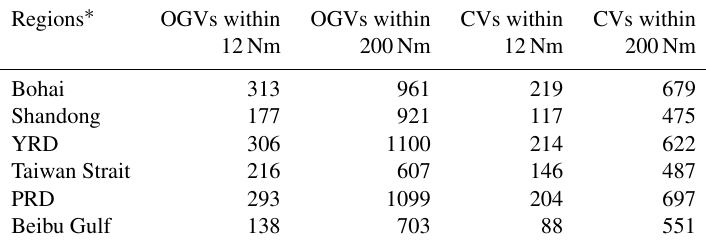
Table 2. Transport distance for OGVs and CVs in different regions (unit: Nm). Regions ∗ OGVs within OGVs within CVs